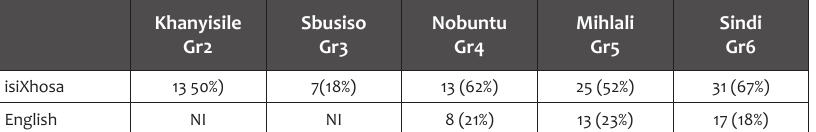
Table 2: Same Grammar Miscues Across English and isiXhosa Texts